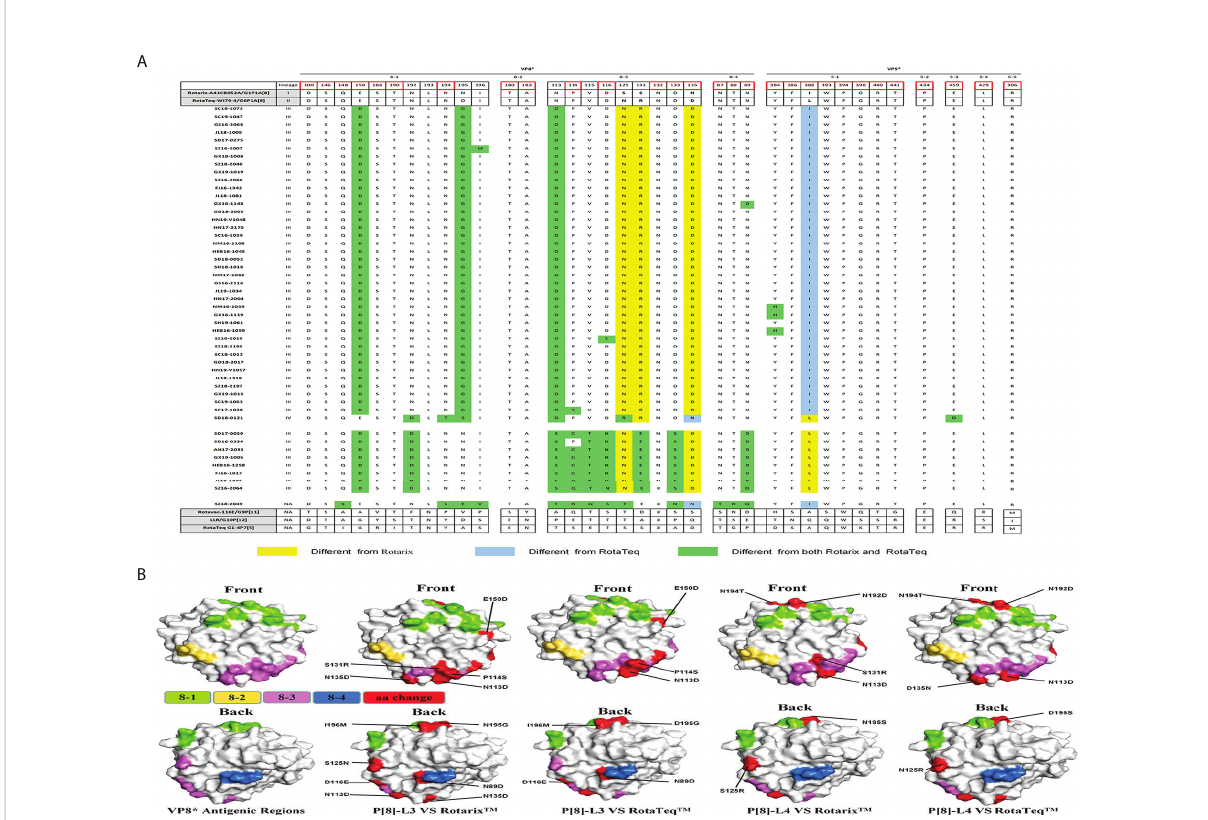
FIGURE 4 (A) Alignment of the antigenic epitopes in VP4 of RVA strains circulating in China with those in Rotarix, RotaTeq, and other vaccines. Red box, the site involved in neutralization escape. (B) Surface representation of the VP8* monomer (PDB 1KQR). Upper and lower images are of the front and rear, respectively, of VP8*. Antigenic epitopes are shown in chartreuse (8-1), yellow-orange (8-2), and violet (8-3). Red surface- exposed residues indicate differences between circulating and vaccine RVA